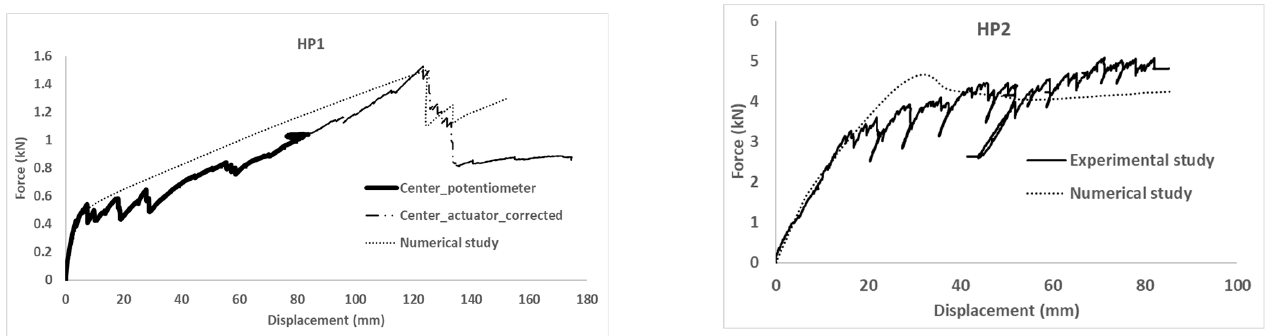
Figure 5. Force vs. displacement plots for experimental specimens and their numerical